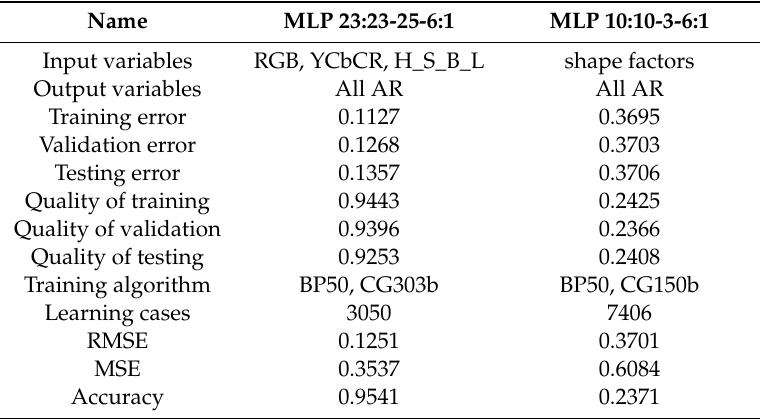
Table 3. Results of training process ANN with a selection of all output variables.